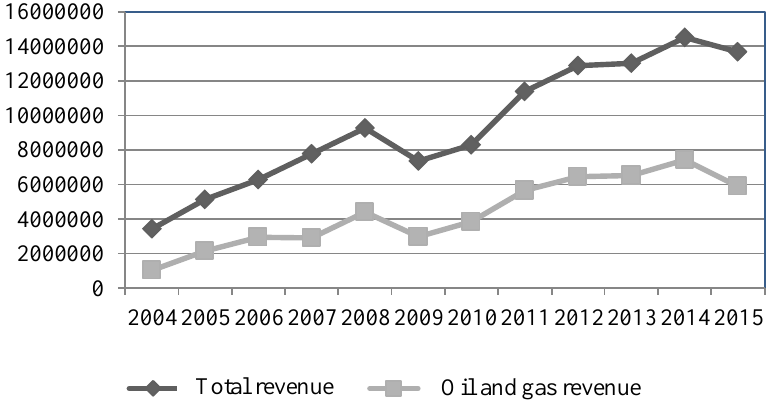
Fig. 7. The trend of federal budget revenues and oil and gas return for 2004-2015, in mln rubles. (compiled by authors to: